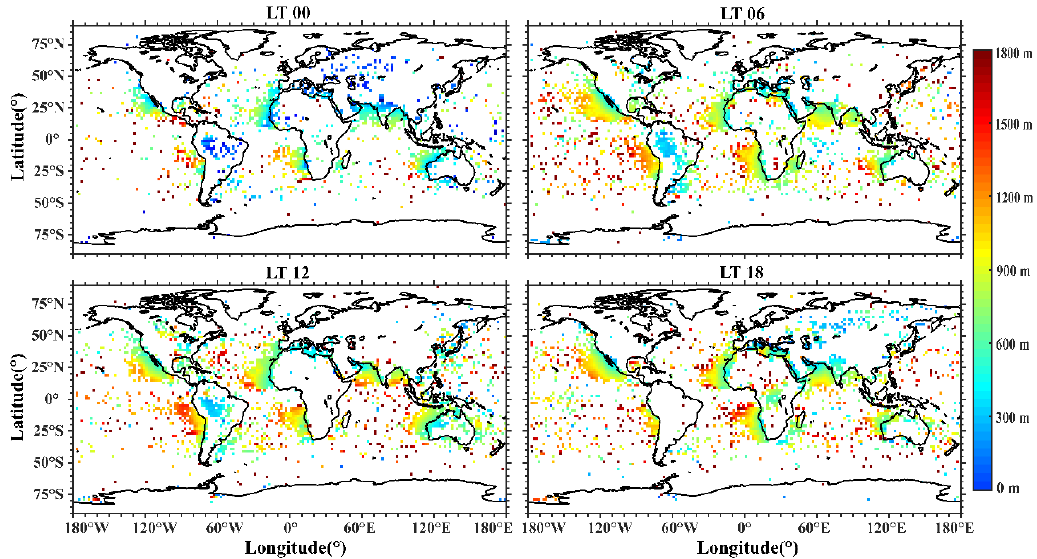
Figure 8. Distribution of the trapping layer altitude with local time variations. The blank grids represent that there is no trapping layer event.